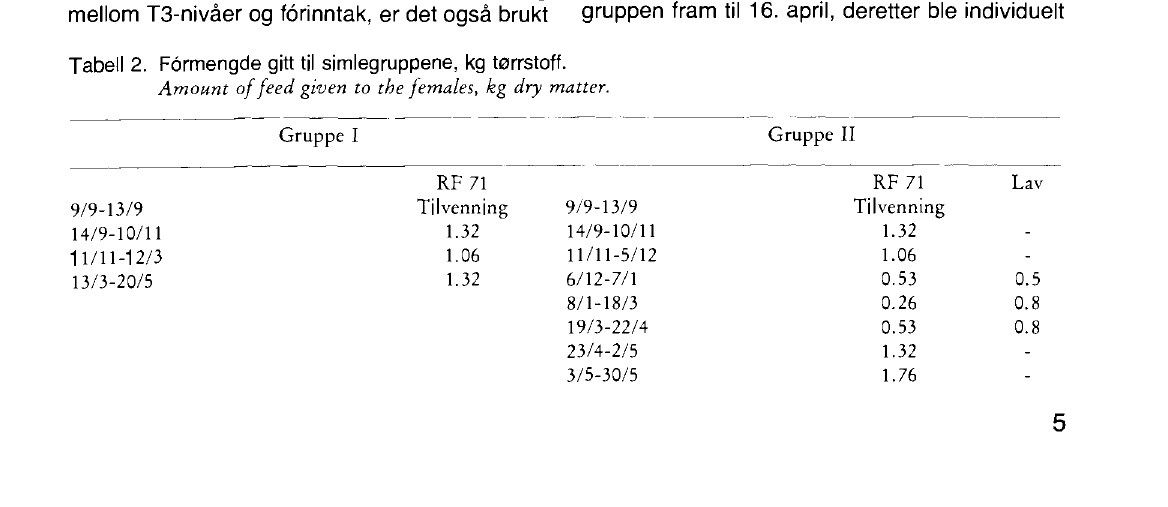
Tabell 2. Formengde gitt til simlegruppene, kg